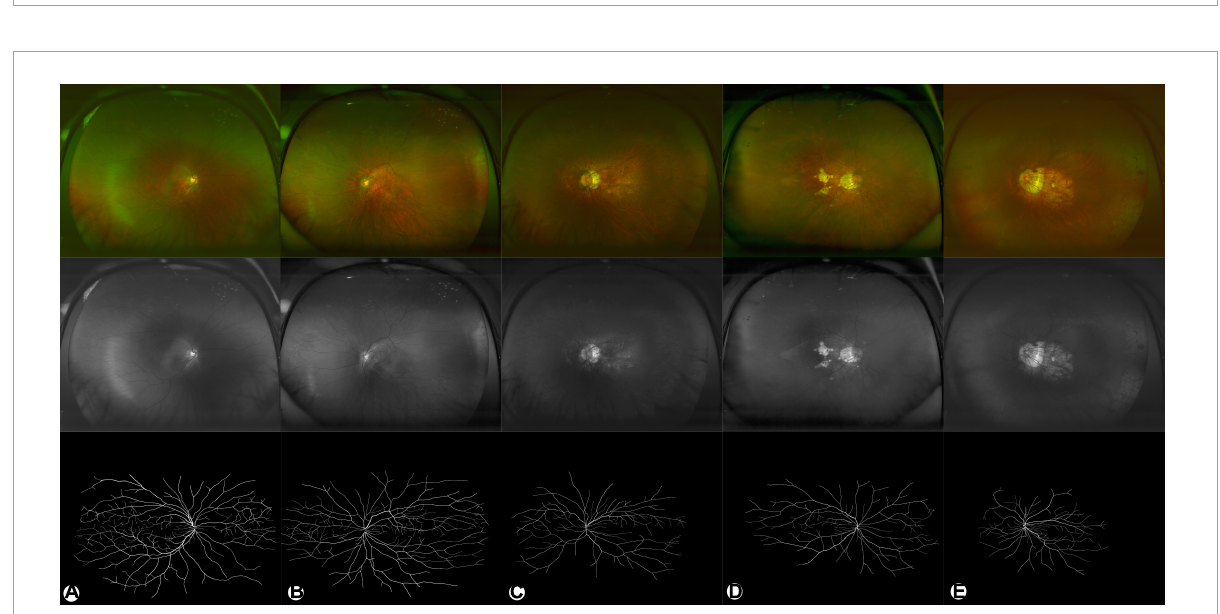
FIGURE2 Representative examples of HM in different degrees. (A–E) are C0–C4, respectively. The upper panel (in color) shows pseudocolor images. The middle panel in gray shows green laser images. The lower panel in black/white shows segmented images of binarized skeletonized blood